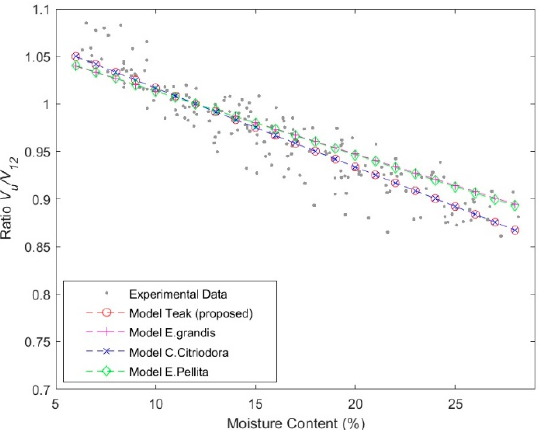
Figure 4. Comparison of adjustment equations to obtain longitudinal references velocity at 12% MC ( V 12 ) for hardwood with the experimental data teak.